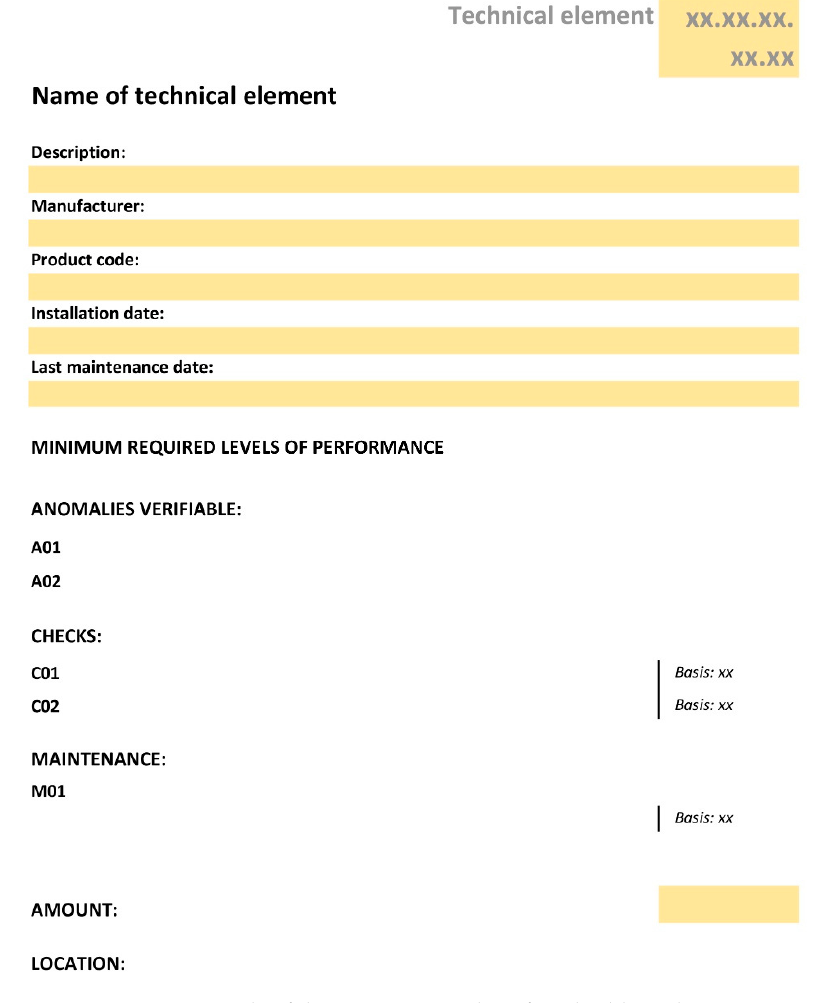
Figure 9. Facsimile of the maintenance sheet for a building element.